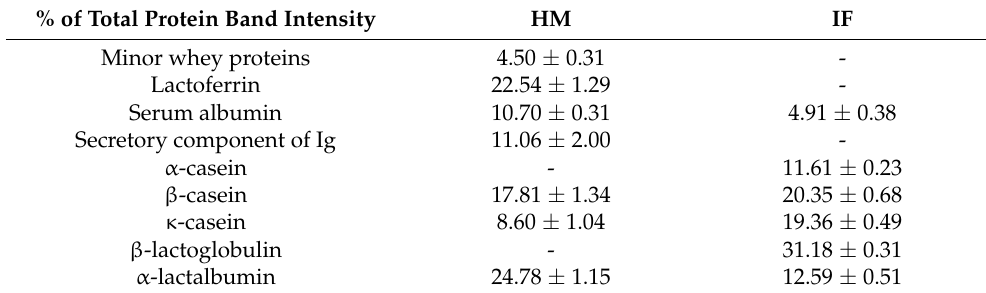
Table 2. Infant milk protein composition as determined by SDS-PAGE and densitometry 1 . % of Total Protein Band Intensity HM IF Minor whey